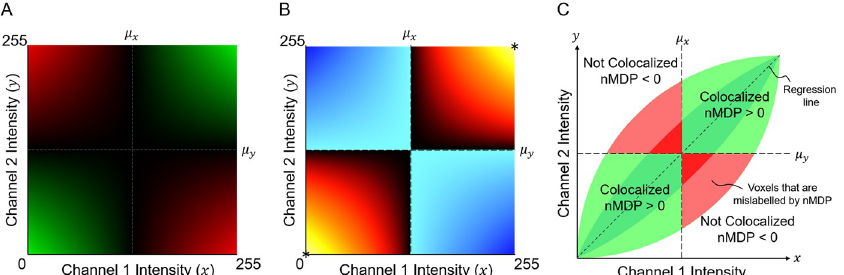
Fig 1. Direct visualisation of the PCC. The relative contribution of each voxel’s colocalisation intensity q to the i correlation coefficient is determined by the individual terms of the summation in the numerator of Eq 3. With x and y axes representing the respective intensities of the two fluorescence channels, we assume a maximum intensity of 255, a mean intensity of 127 and a minimum intensity of 0 for each channel. A) The relative contribution to the PCC is shown for all possible values of q i , with green representing a positive and red representing a negative contribution. B) according to the nMDP colourmap [11], calculated The colour that would be assigned to each voxel with intensity q i using Eq 1. Note that, at the means, there are sudden changes in the colour assigned by nMDP. C) How nMDP labels each colocalisation intensity q as colocalised or not-colocalised based on its position relative the means. A i colocalisation intensity distribution commonly seen for strongly correlated fluorescence channels is shown, with darker shades indicating strong positive correlation and lighter shades indicating weaker positive correlation [3]. The areas marked in red correspond to positively correlated colocalisation that are indicated as negatively correlated when using